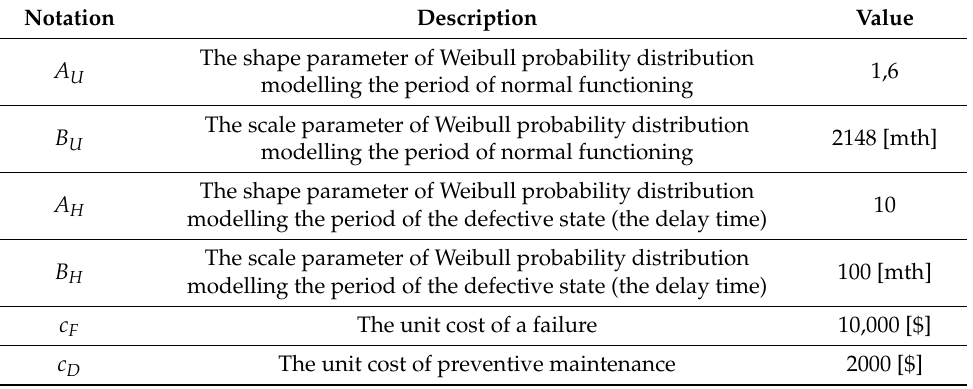
Table 3. Parameters of the failure